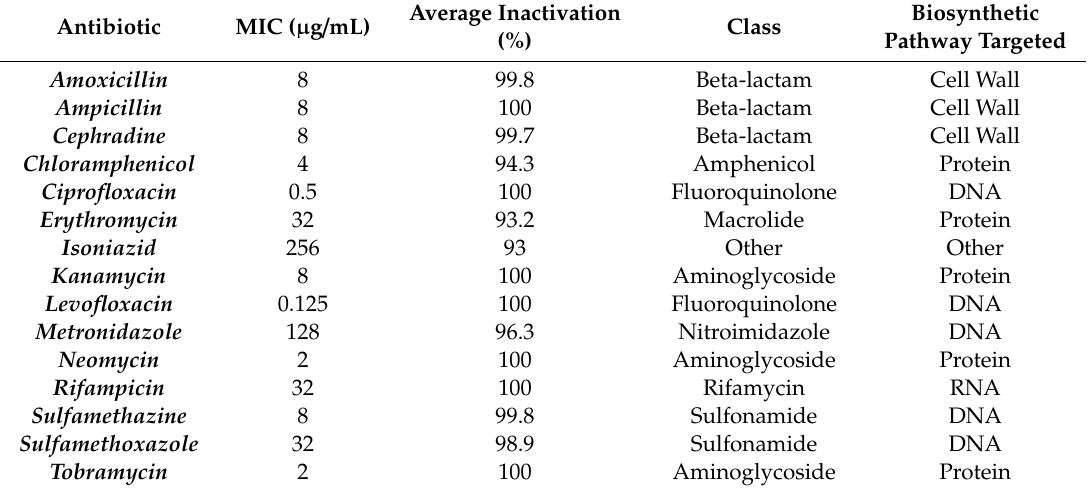
Table 1. Classification of the antibiotics tested, the biosynthetic pathway targeted and their Minimum Inhibitory Concentration (MIC). The average bacterial inactivation after exposure to 4 X MIC for 3 h was determined by plate counting Colony Forming Units (CFUs). The results are shown as the percentage variation in regard to the control, which confirms the desired cell